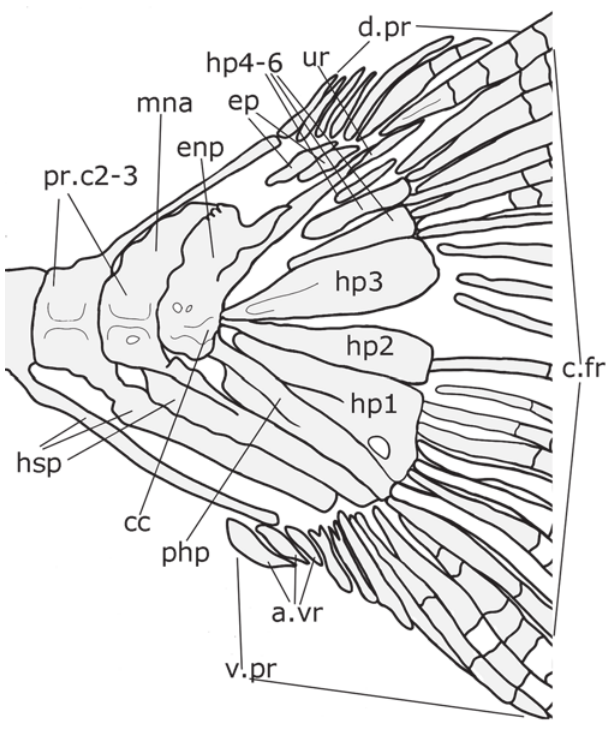
Fig. 6. Diagramatic representation of the caudal-fin skeleton of † Bryconetes enigmaticus n. gen. n. sp. based on the holo- type (UFRGS 19114). Abbreviations: a.vr, anterior ventral procurrent caudal-fin rays; cc, compound centrum; c.fr, prin- cipal caudal-fin rays; d.pr, dorsal procurrent caudal-fin rays; enp, especialized neural arch of compound centrum; ep, epurals; hp1-6, hypurals 1 to 6; hsp, haemal spine; mna, modi- fied neural arch of preural centrum 2; php, parhypural; pr.c2- 3, preural centra 2-3; ur, uroneural; v.pr, ventral procurrent caudal-fin